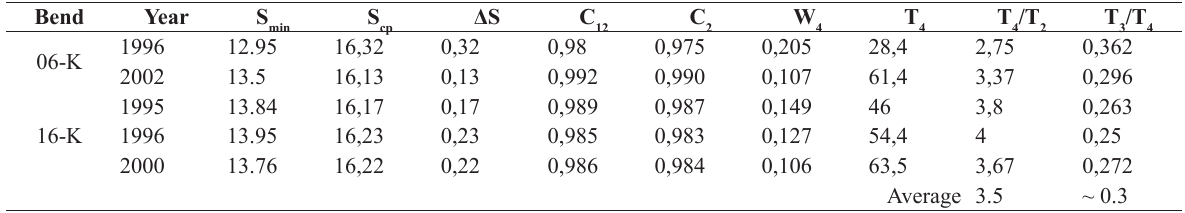
Table 10. Estimated values of FAC rate and residual lifetime ( W account the bend